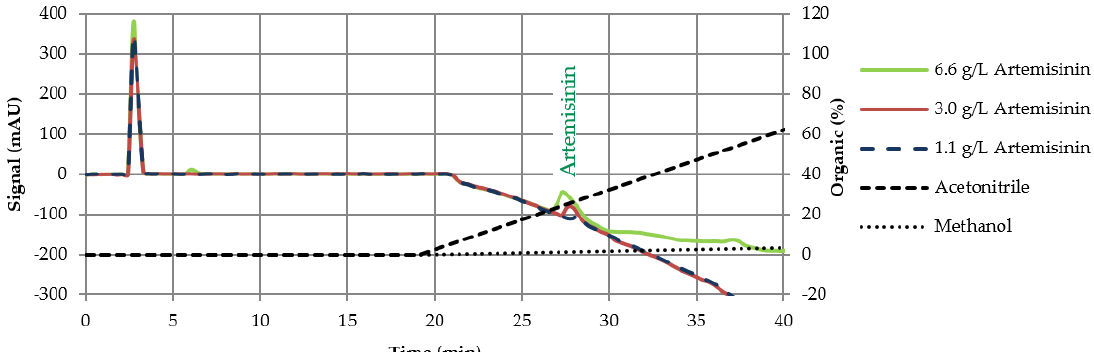
Figure 7. Comparison of three different reference solutions (at 190 nm) on LiChrospher 300 CN column in RP-Mode, elution from 100 vol % buffer in gradient mode (10 column volume (CV)) to acetonitrile/methanol (95/5 vol %).